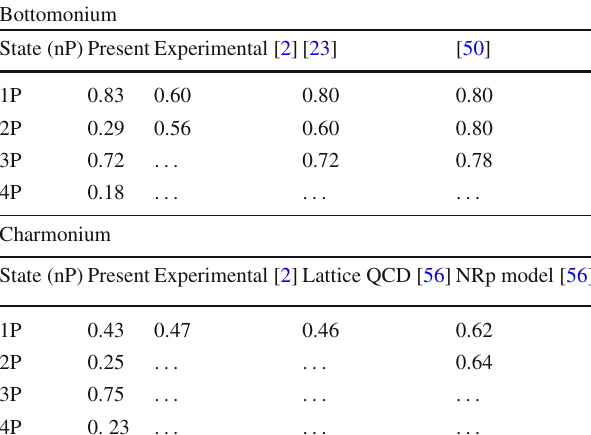
Fig. 2 Mass spectrum of Charmonium